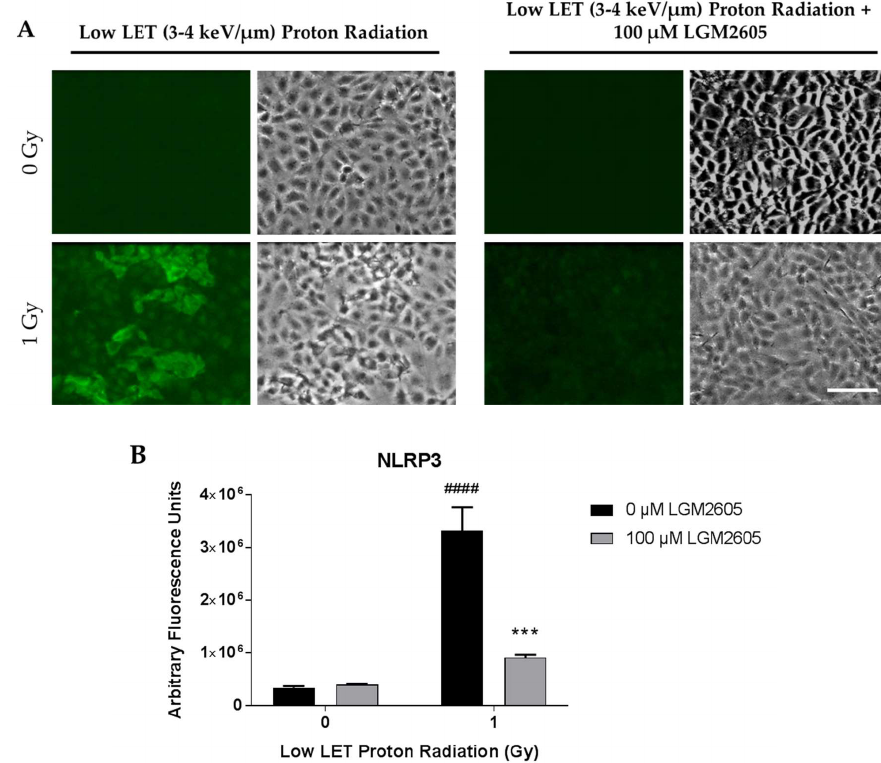
Figure 3. Evaluation of LGM2605 inhibition of NOD-like receptor protein 3 (NLRP3) activation in in vitro lung vascular networks (flow-adapted endothelial cells) exposed to low LET proton radiation.